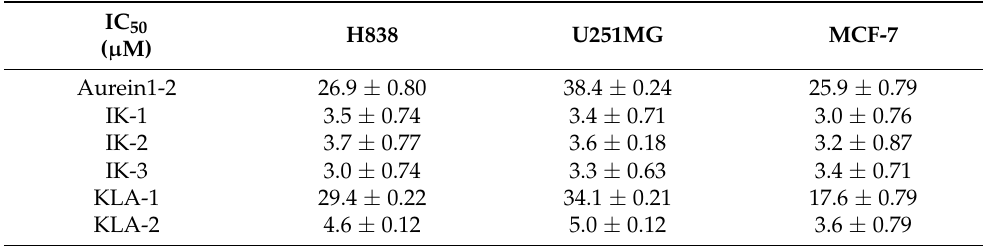
Table 4. The calculated IC 50 values ( µ M) of aurein 1.2 and its